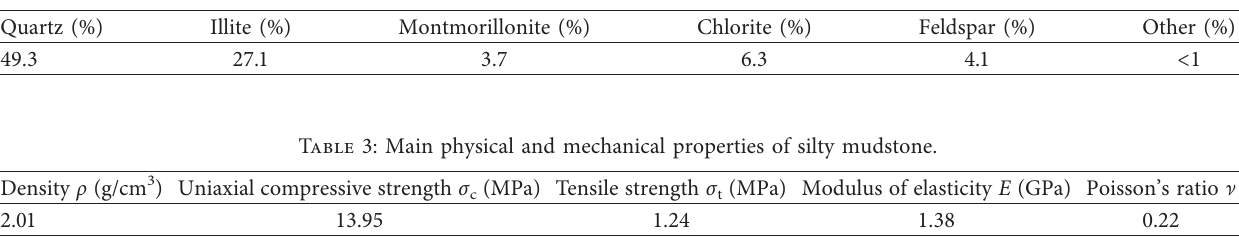
Figure 1: X-ray diffraction pattern of silty mudstone. Table 2: Mineral compositions of silty mudstone.